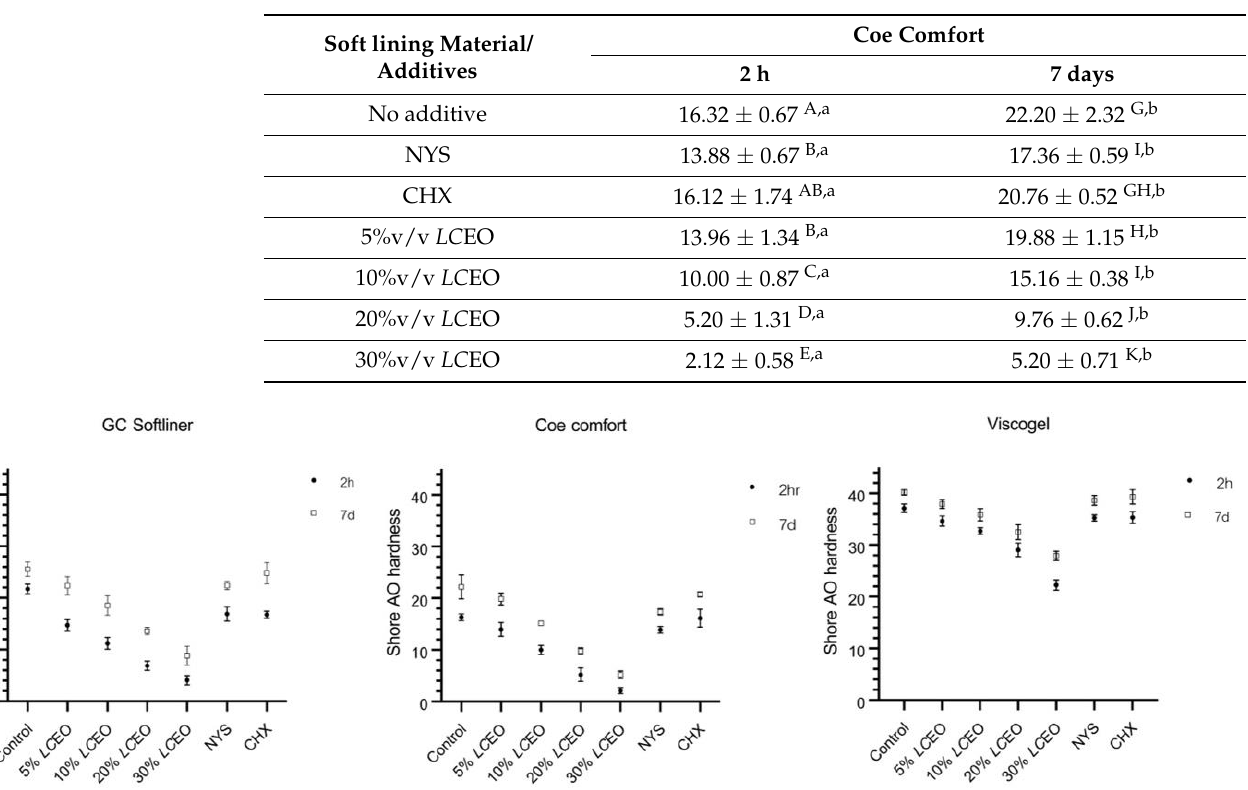
Table 8. Shore AO hardness values of Coe comfort with and without additives are shown as mean ± SD ( n = 5). Same uppercase superscript letters denote no significant difference ( p > 0.05) among additives only within the same column. Same lowercase superscript letters denote no significant difference between 2 h and 7 days ( p > 0.05).